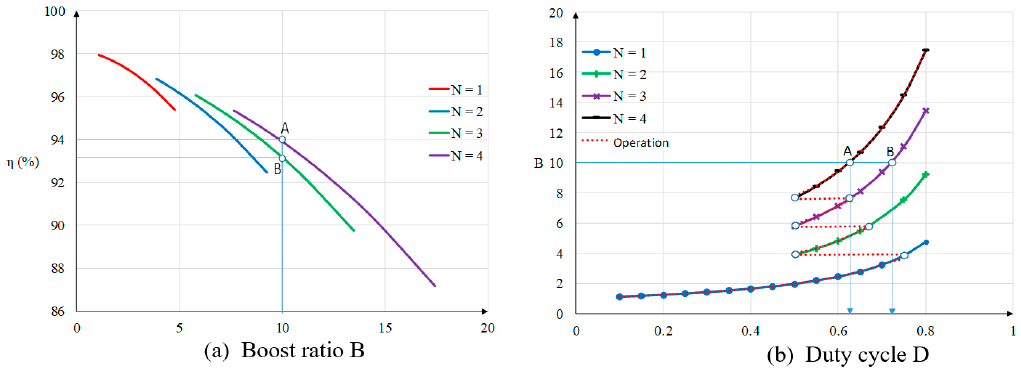
ffi ciency η ( a ) and boost ratio B ( b ) with R Figure 6. The graph of efficiency η ( a ) and boost ratio B ( b ) with R Load is 250 Ohm. Figure 6. The graph of e